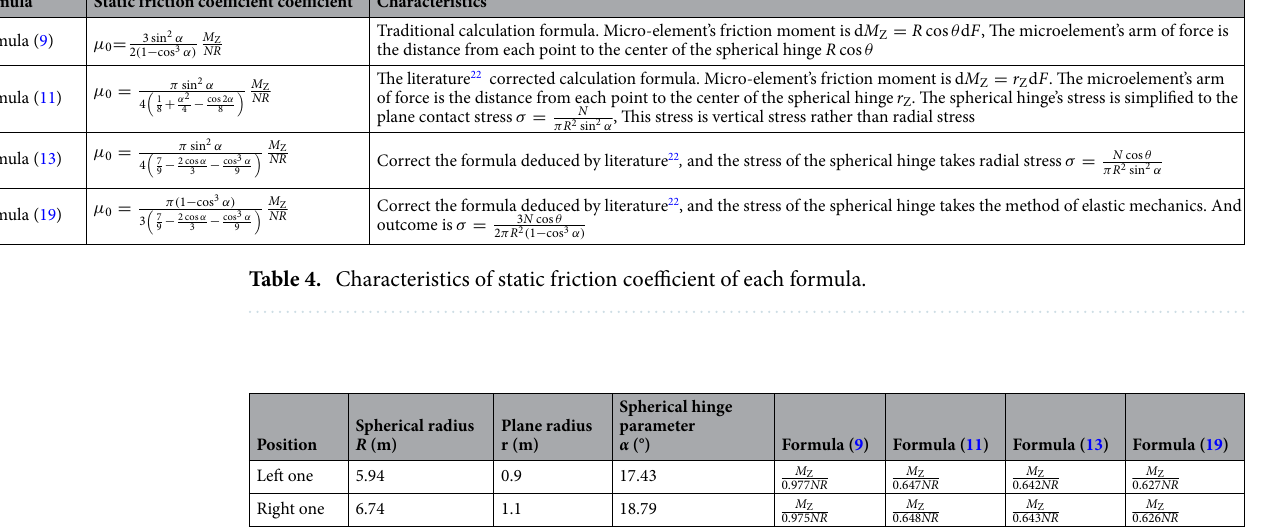
Table 5. Spherical hinge’s static friction coefficient.